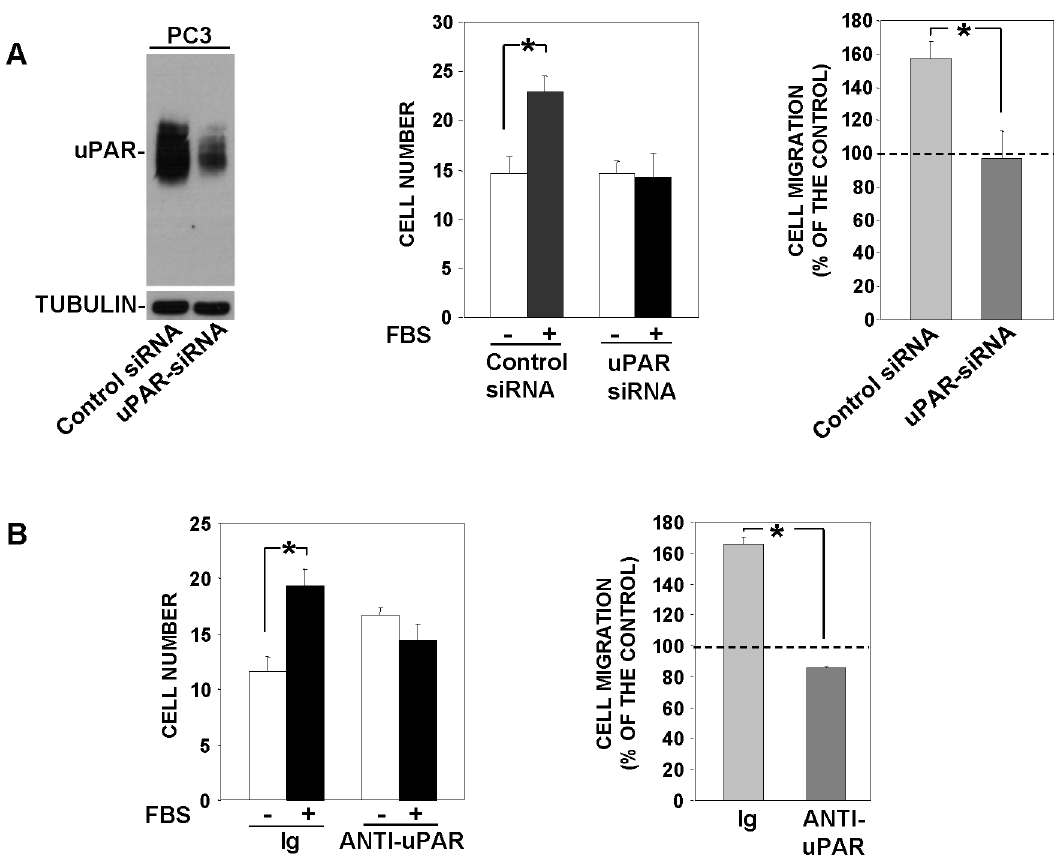
Figure 8. uPAR depletion or blocking impairs migration of uPAR-expressing cells. A: Prostate carcinoma (PC3) cells were transfected with a uPAR-targeting siRNA or a non-targeting control siRNA; then, cells were partly lysed for Western blot analysis with a uPAR-specific antibody (left) and partly loaded in Boyden chamber and allowed to migrate toward 10% FBS. Migrated cells were fixed, stained with hematoxylin, and counted (middle panel). The values are the mean 6 SD of a representative experiment performed in triplicate. Results of the migration assay are also expressed as percentage of cells migrated towards serum over the cells migrated without serum; 100% values represent cell migration in the absence of chemoattractant (right). (*) p # 0.05, as determined by the Student’s t test. B: PC3 cells were pre-incubated with nonimmune immunoglobulins (Ig) or anti-uPAR polyclonal antibodies, plated in Boyden chambers and allowed to migrate toward 10% FBS. Migrated cells were fixed, stained with hematoxylin, and counted (left). Results of the migration assay are also expressed as percentage of cells migrated towards serum over the cells migrated without serum; 100% values represent cell migration in the absence of chemoattractant (right). The values are the mean 6 SD of three experiments. (*) p # 0.05, as determined by the Student’s t